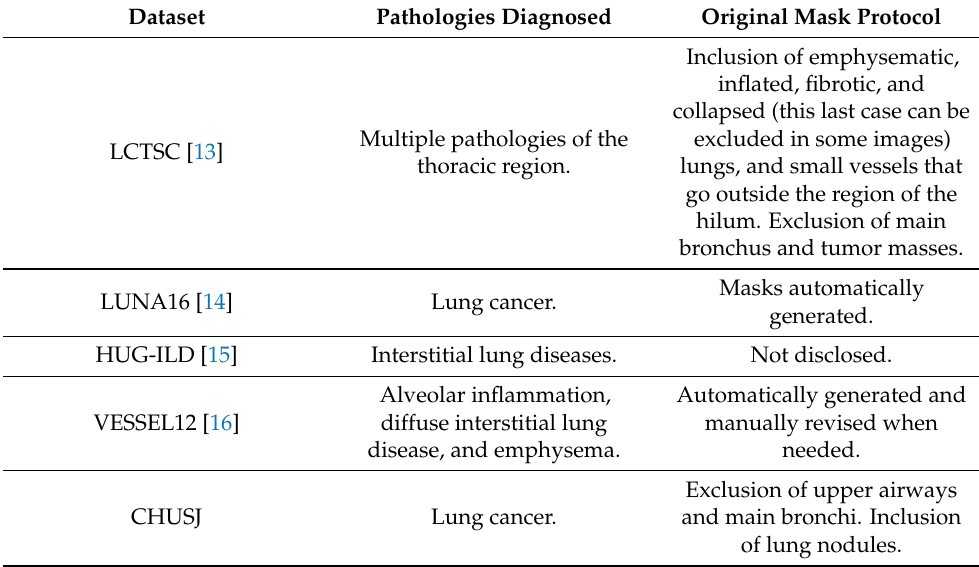
Table 2. Datasets description of pathologies included and protocols utilized in the annotation